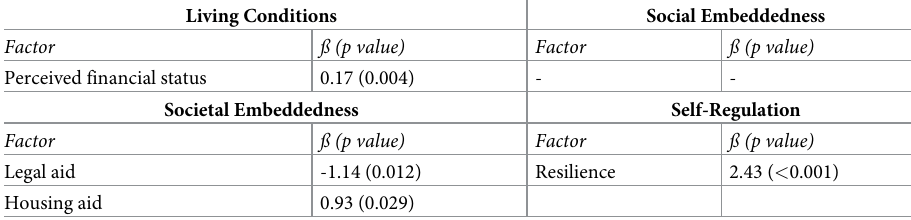
Table 5. US final model: SQM factors that are independently associated with quality of life (R 2 = 0.49). Living Conditions